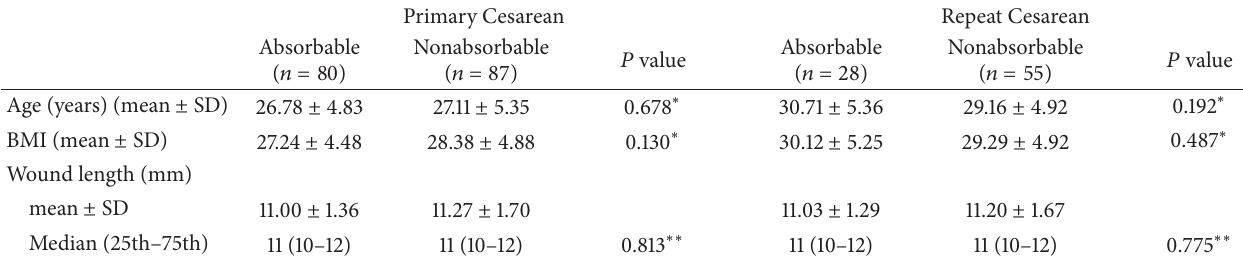
Table 1: Descriptive statistics of study groups.